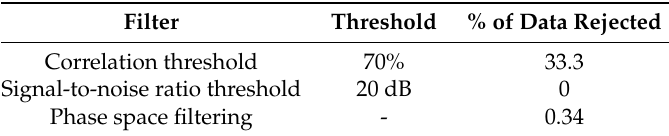
Table 1. Summary of ADV quality